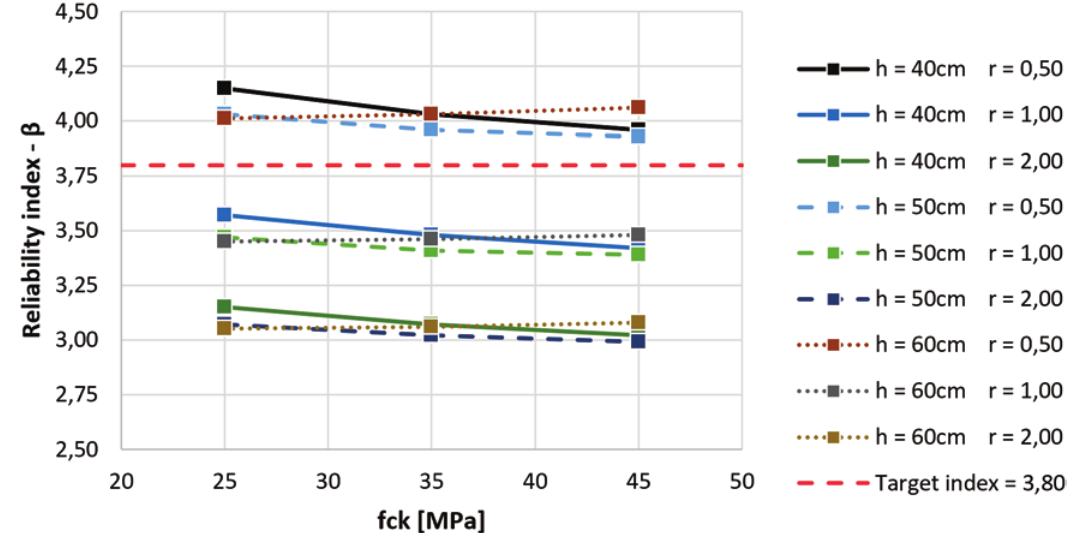
Variation of the reliability index as a function of fck (pk =